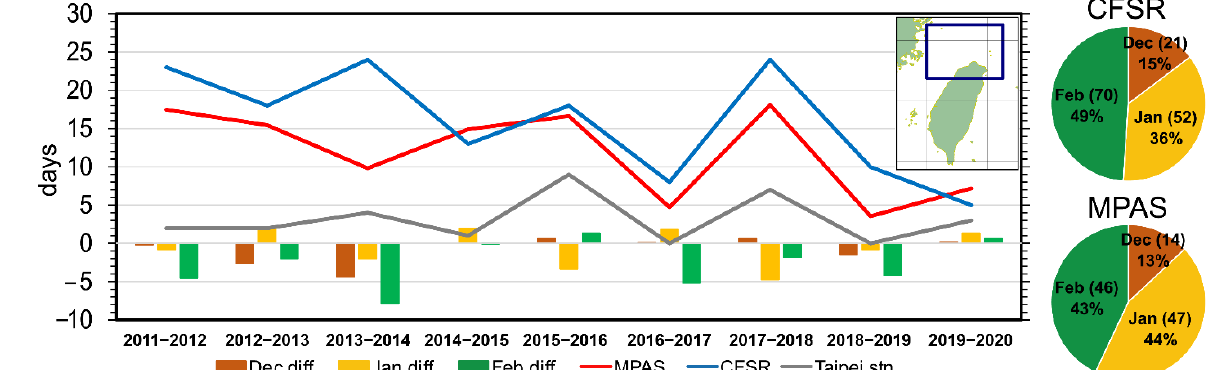
Figure 12. Annual trend of cold events days for MPAS (red line), CFSR (blue), and Taipei station (gray). The cold events are defined as the minimum 2-m temperature less than 10 °C in the region of 24.75 – 26.5° N, 120 – 122.5° E for MPAS and CFSR. Bars represent the number of days between MPAS and CFSR in December (brown), January (yellow), and February (green). The pie chart shows the event days in December (brown), January (yellow), and February (green) for MPAS and CFSR.